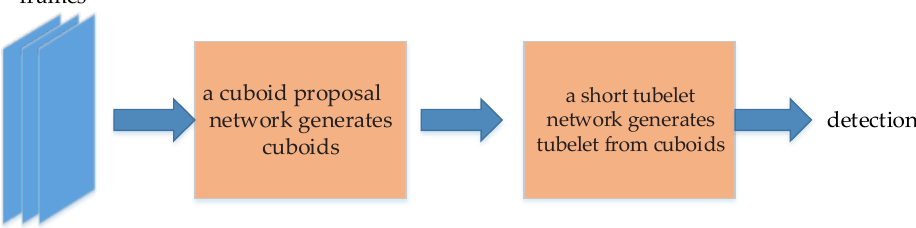
Figure 28. The work flow of High Quality Object Linking.